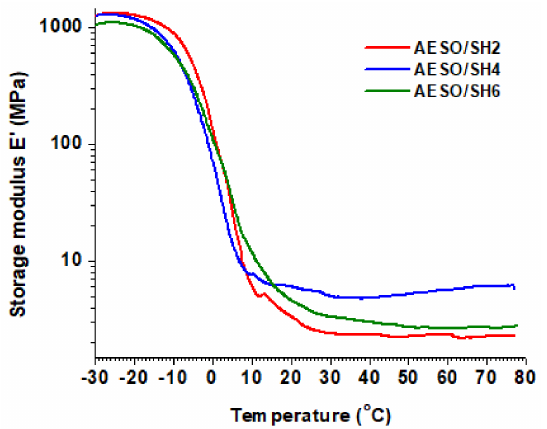
Figure 4. The storage modulus E (cid:48) versus temperature curves of the cross-linked polymers prepared.